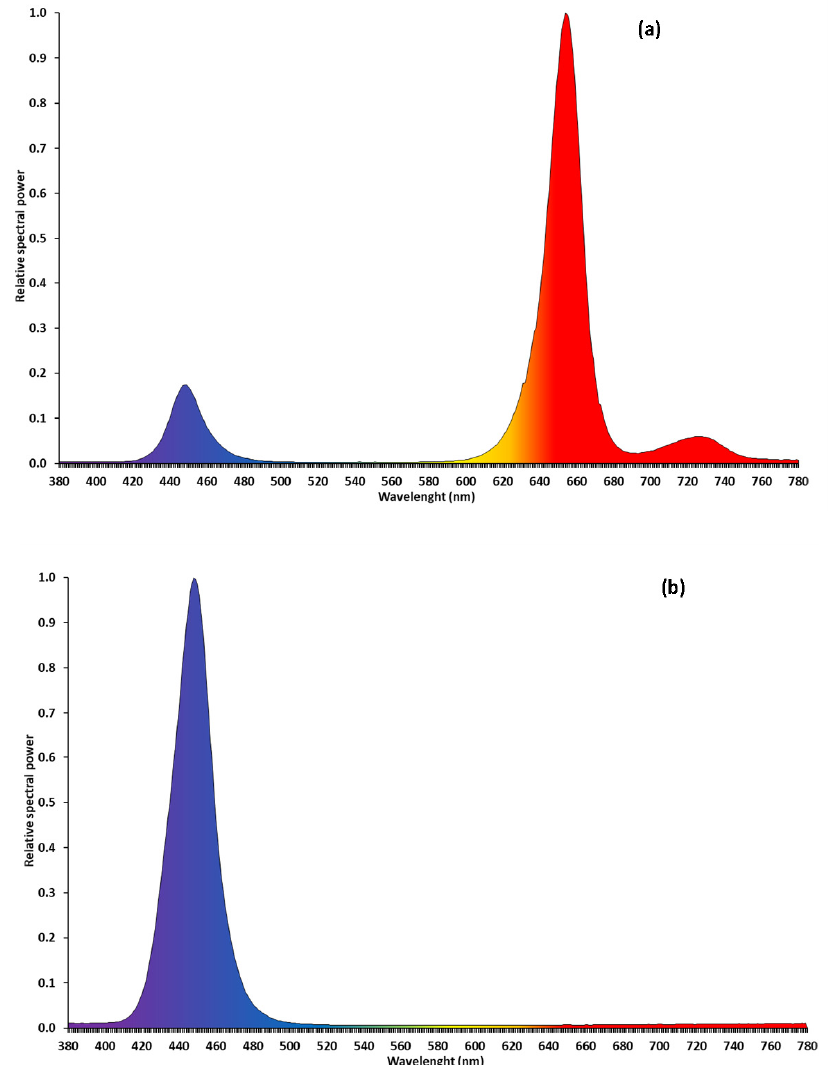
Figure 1. Relative spectral power of the CTRL light treatment ( a ) and B light treatment ( b ).